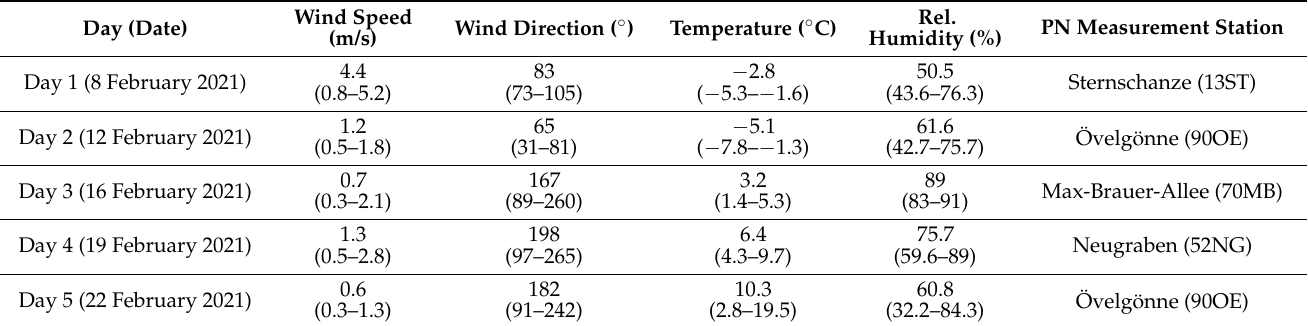
Table 2. List of the selected days of this study together with the meteorological conditions and the PN measurement site. Wind speed, wind direction, temperature, and relative humidity are given as daily mean of the respective day. In brackets are the minimum and maximum hourly values recorded on that